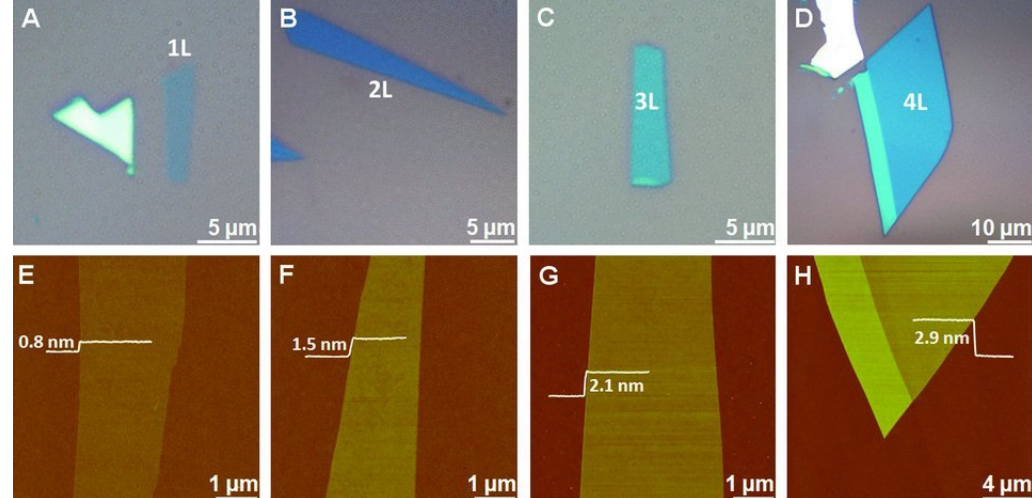
Figure 4. Mechanically exfoliated single- and multilayer MoS 2 nanosheets on Si/SiO 2 . ( A – D ) Optical microscope and ( E – H ) AFM images of MoS 2 nanosheets. The single MoS 2 sheet thickness is 0.8 nm ( E ), while the thickness of two ( F ), three ( G ), and four ( H ) layers of MoS 2 nanosheets is 1.5, 2.1, and 2.9 nm, respectively. Reprinted with permission from Ref. [41]. Copyright 2012 Wiley-VCH Verlag GmbH & Co.